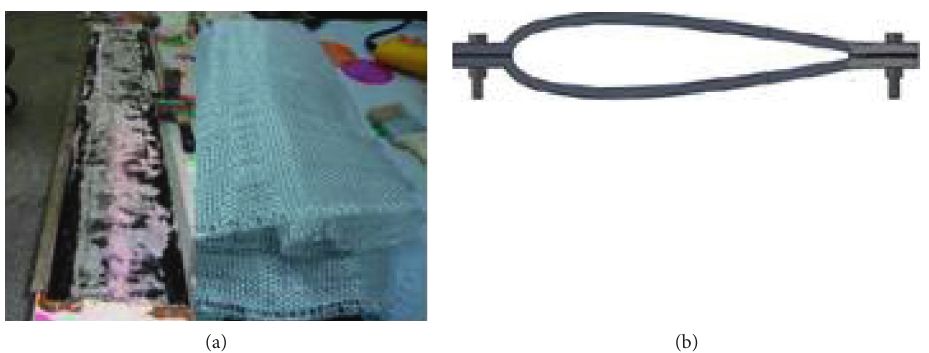
Figure 3: Mold making process. (a) Fiberglass layup. (b) Complete mold